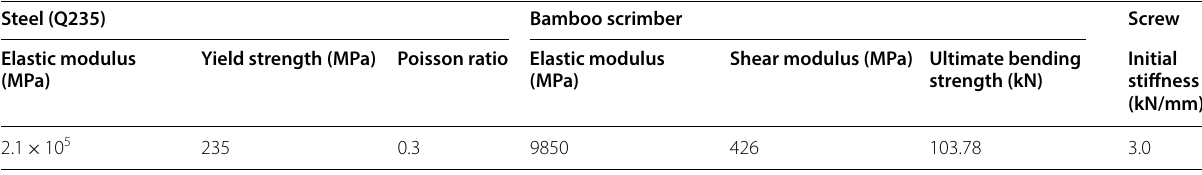
Table 1 Mechanical properties of steel, bamboo and